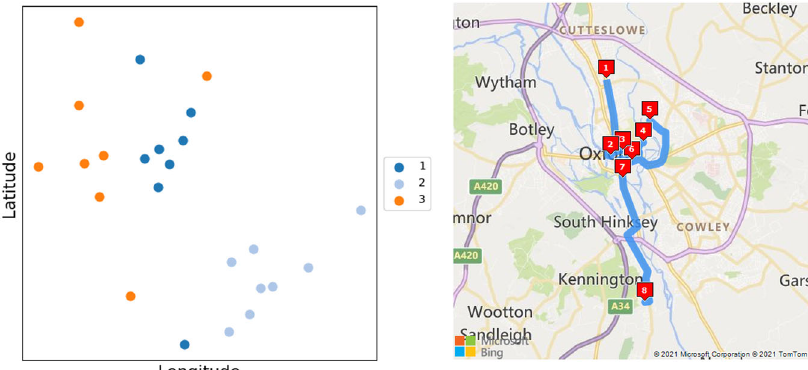
Fig. 1 Example output produced by Vaximap. Left: 24 patients have been sorted into three clusters of size eight, the spatial distribution of which is shown here. Right: the optimal driving route for visiting the patients in cluster 1 (dark blue). [Map reproduced with permission from Microsoft under Bing Maps API Print Rights, non-pro fi t use 27 .].